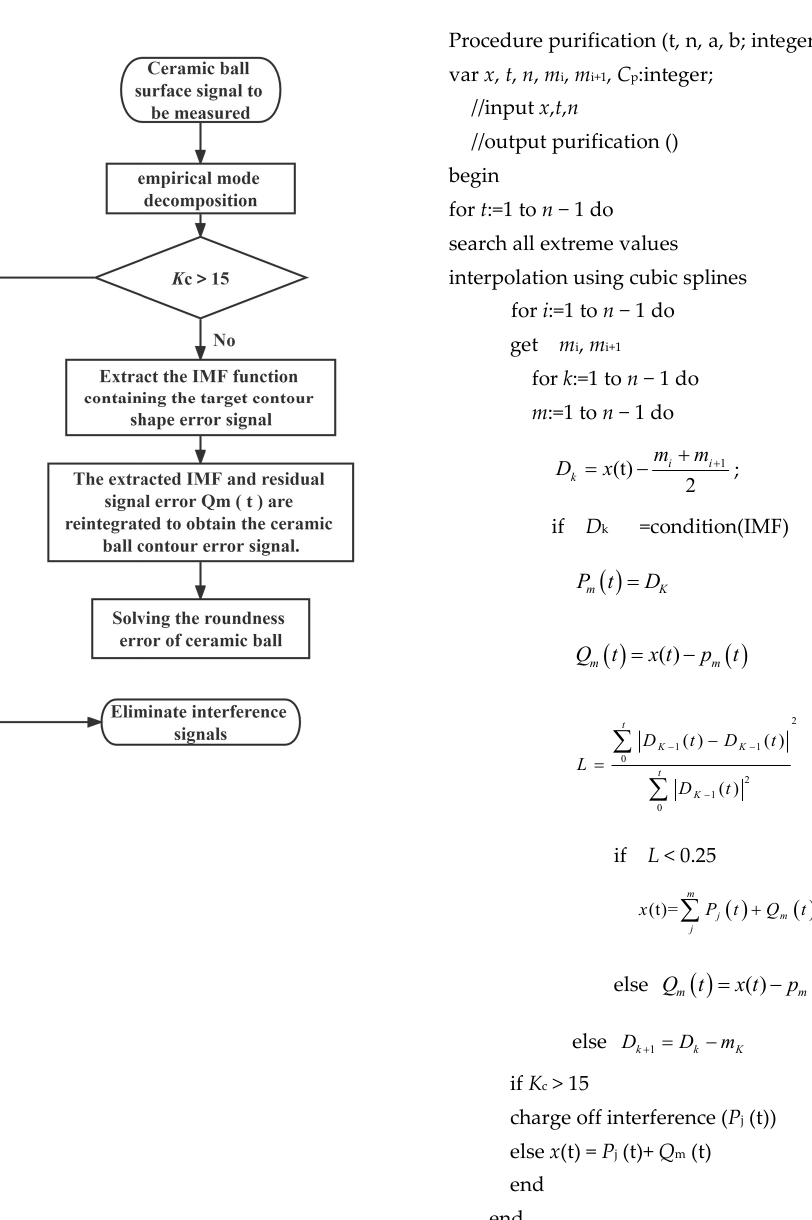
Figure 5. Ceramic ball surface roundness deviation signal extraction method.